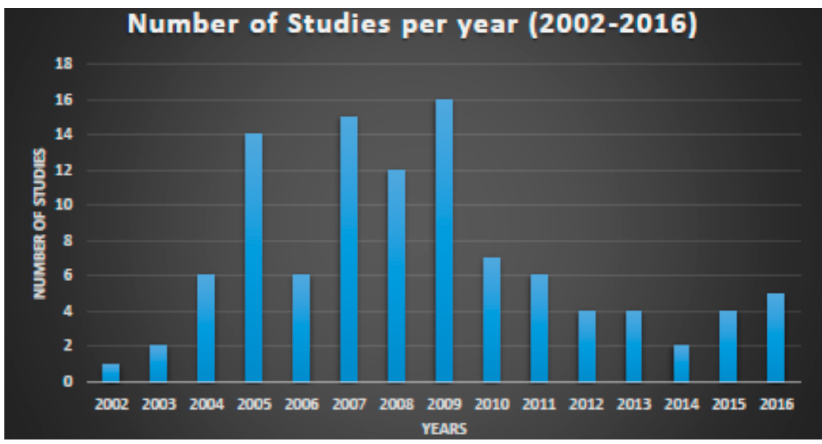
Figure 1. Number of early phase clinical trials per year, using proteomic approaches. Data from clinicaltrials.gov 2002–2016.